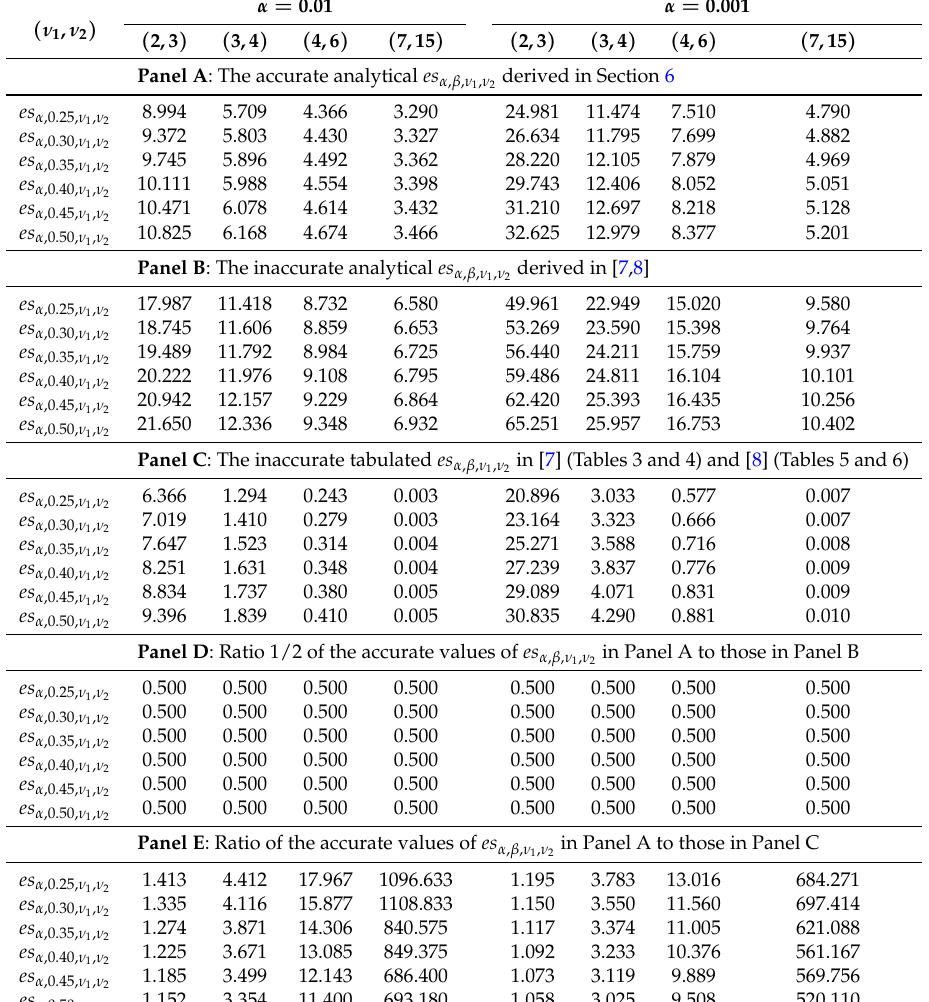
Table 2. Numerical comparison of the accurate versus inaccurate expression for expected shortfall in the case of a multivariate Student t mixture. The table reports the accurate analytical (panel A), inaccurate analytical (panel B), and inaccurate numerically tabulated (panel C) values of es α , β , ν the mixture of multivariate Student t distributions governing the individual risky returns in a linear, mean-zero, and unit-scale portfolio, as well as the respective ratios of accurate versus inaccurate analytical (panel D) and accurate analytical versus inaccurate numerically tabulated (panel E) values across different tail quantiles α = 0.01 and 0.001 (left and right panel), different mixture weights β = 0.25,0.30,0.35,0.40,0.45,0.50 (different rows), and different pairs of degrees of freedom ( ν 1 , ν 2 ) = ( 2,3 ) , ( 3,4 ) , ( 4,6 ) , ( 7,15 ) (different columns). The accurate expression in panel A reflects the derivations in this paper (Theorems 3 and 4). The inaccurate expression in panel B is originally due to [7] (Theorem 4.2) and [8] (Theorem 5.4), while the inaccurate values in panel C are the ones numerically tabulated in [7] (Tables 3 and 4) and [8] (Tables 5 and 6).